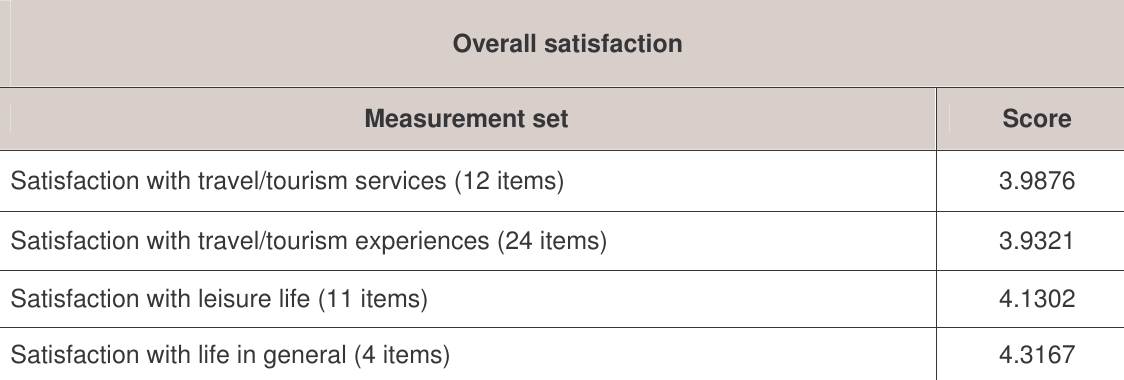
Table 7: Overall mean scores for satisfaction in each measurement